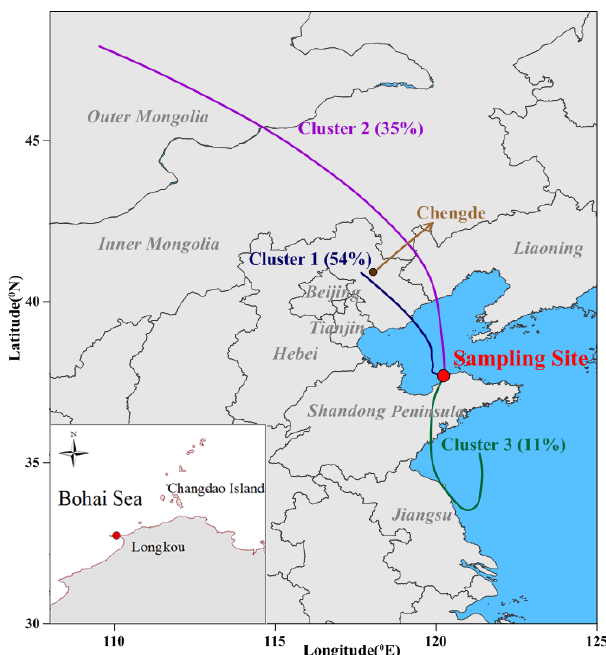
Figure 1. The sampling site and 48h back trajectory clusters during the sampling